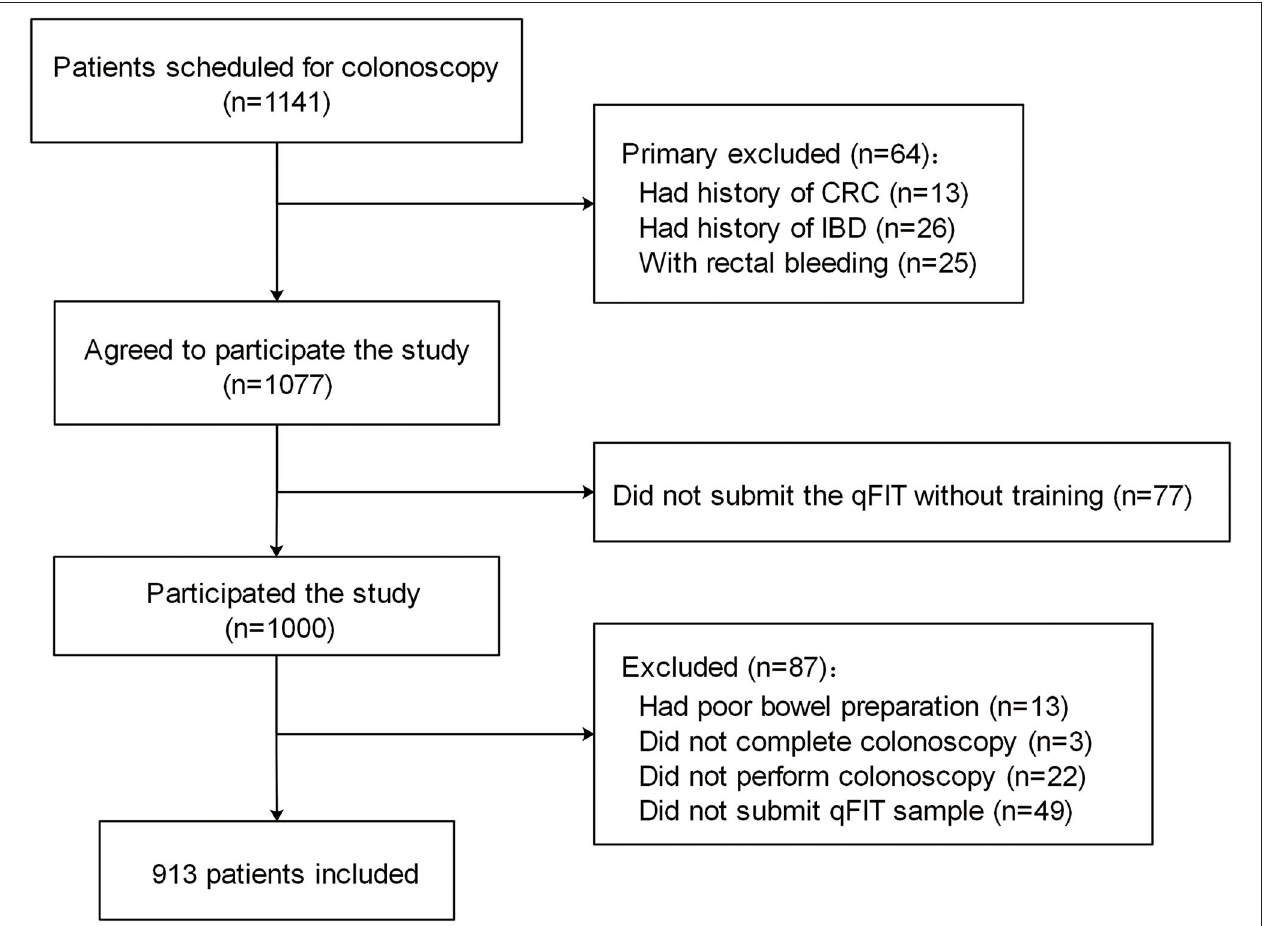
FIGURE 1 | Study of the flow diagram. CRC, colorectal cancer; IBD, inflammatory bowel disease.